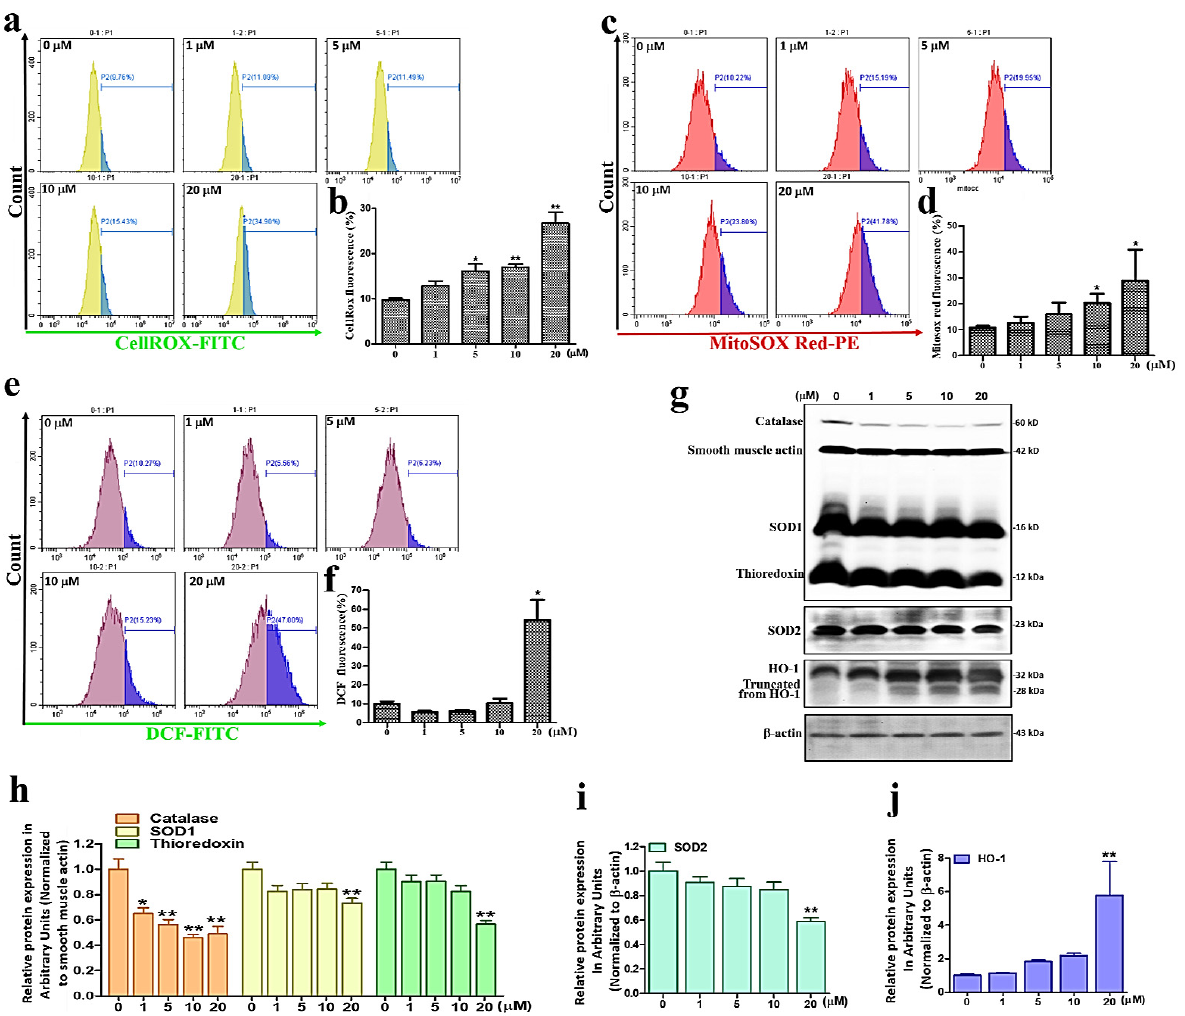
Figure 3. ROS and relevant protein expression levels measured after 24 h of sinularin treatment in U87 MG cells. ( a ) Detection of ROS levels in mitochondria and the nucleus using CellROX TM Green. ( b ) Analysis of CellROX TM Green signals. ( c ) Detection of mitochondrial O 2 •− levels using MitoSOX TM Red. ( d ) Analysis of MitoSOX TM Red signals. ( e ) Detection of intracellular ROS levels in mitochondria using CM-H 2 DCFDA. ( f ) Analysis of DCF signals. ( g ) Western blot measurement of catalase, SOD1, SOD2, thioredoxin, and HO-1. Full, uncropped Western blot gel can be found on Supplementary File Figure S1b. ( h ) Analysis of catalase, SOD1, and thioredoxin. ( i ) Analysis of SOD2. ( j ) Analysis of HO-1. Each bar represents the mean ± standard error of the mean. * p < 0.05 and ** p < 0.01 relative to